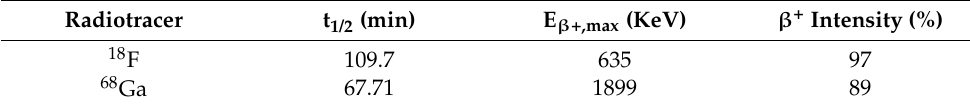
Table 1. Physicochemical characteristics of different radiotracers ( 18 F and 68